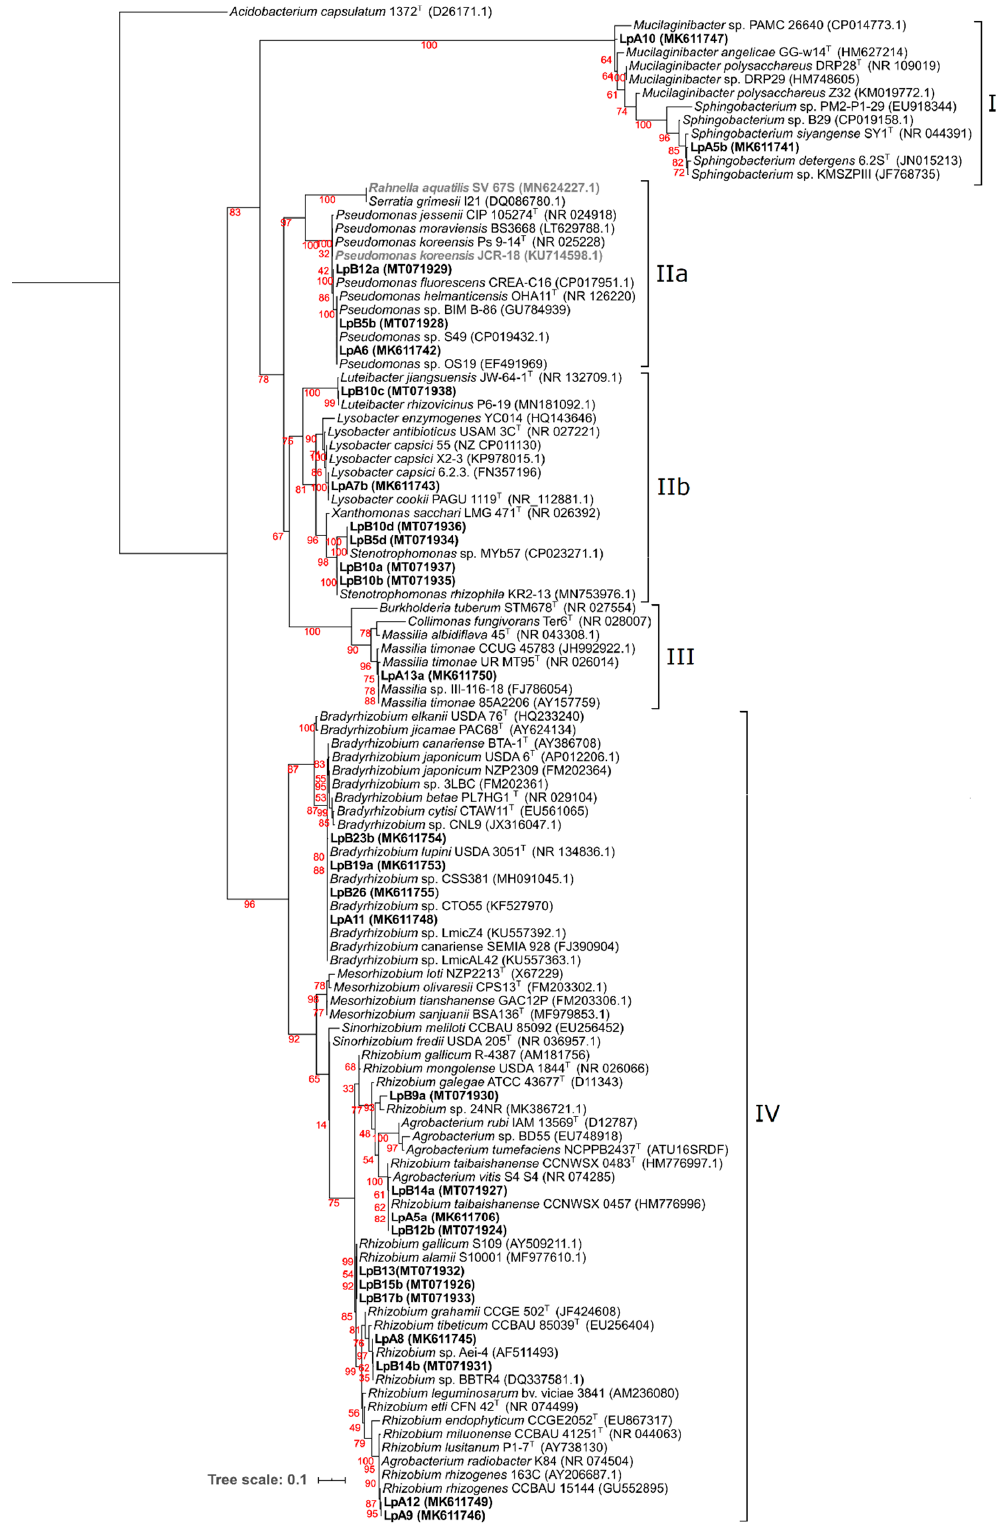
Figure 2. Phylogeny of 16S rRNA based on 920 positions. Analyses were conducted with IQ-tree using Maximum Likelihood (ML) and ModelFinder (Best model: TIM3 + F + I + G4) methods. Confidence levels of bootstrap are presented in red near each node. NCBI Genebank accession codes are presented next to each strain. Acidobacterium capsulatum 1372 T (D26171.1), a bacterium from the Acidobacteria phylum, was selected as an outgroup. Isolates obtained from L. parviflorus nodules are in